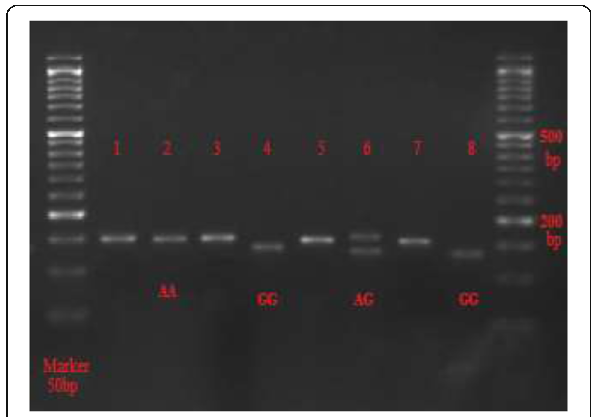
Fig. 3 The gel photograph represents the digestion fragments with HpaII . Before HpaII digestion: Lanes 1,3, 5 and 7: 151-bp fragments. After HpaII digestion: Lane 2: 151-bp band representing the homozygous AA genotype (mutant type); Lanes 4 and 8: 133-bp band representing the homozygous GG genotype (wild type); Lane 6: 151- and 133-bp bands representing AG genotype (heterozygous)